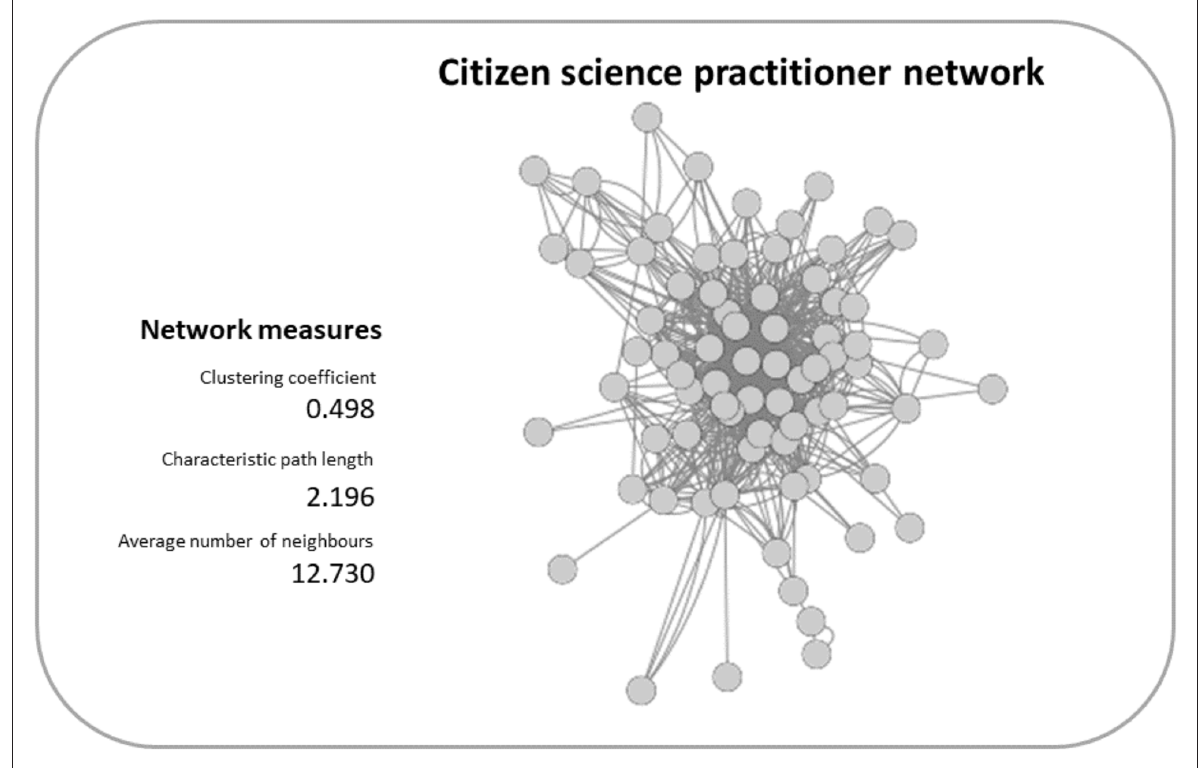
Figure 2 Graphic representation of the citizen science practitioner network and network statistics.